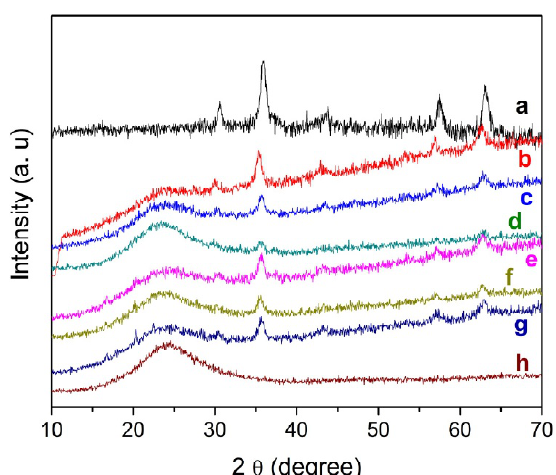
Fig. 3. X-ray diffraction patterns (XRD) of (a) mag- netite, (b) SiO -Mag (1:8), (c) SiO -Mag (1:16), (d) 2 2 SiO -Mag (1:24), (e) SiO -Mag-IBU (1:8), (f) SiO 2 2 Mag-IBU (1:16), (g) SiO -Mag-IBU (1:24) and (h) SiO 2 samples.